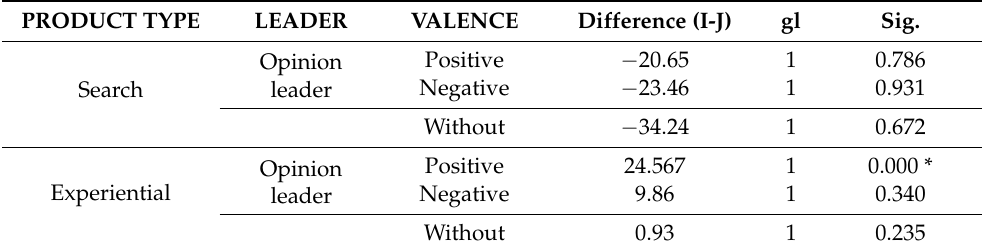
Table 5. OL eWOM, product type, and valence interaction